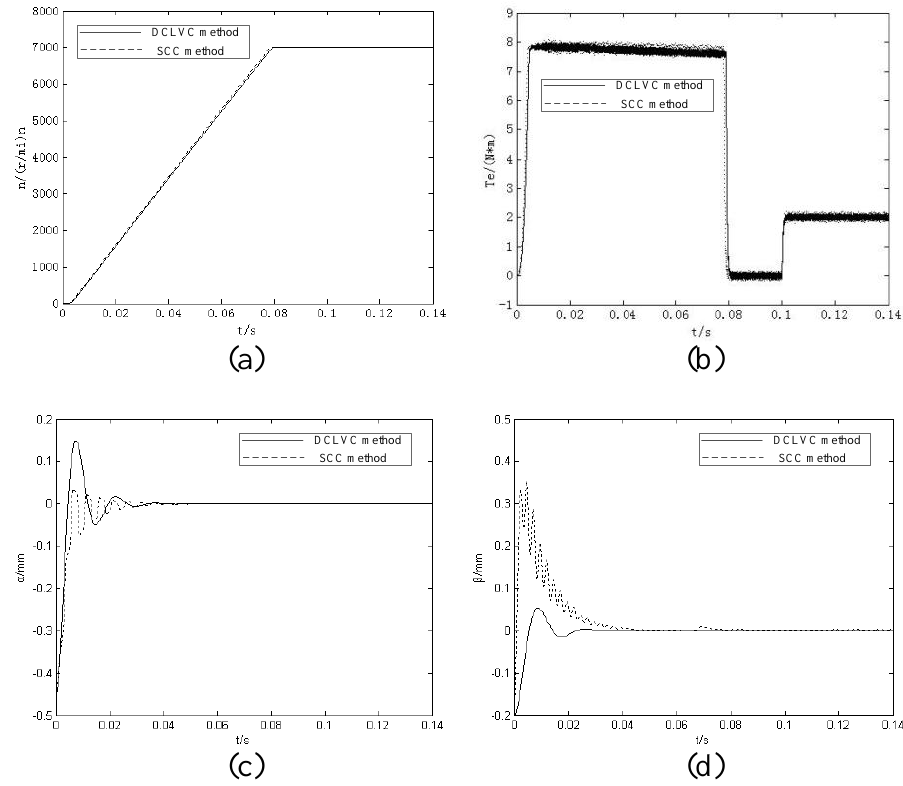
Figure 12. Simulation results of the control system of SBPMSM. ( a ) Comparison of speed characteristics; ( b ) Comparison of torque characteristics; ( c ) Comparison of the α-axis displacements; ( d ) Comparison of the β-axis displacements.